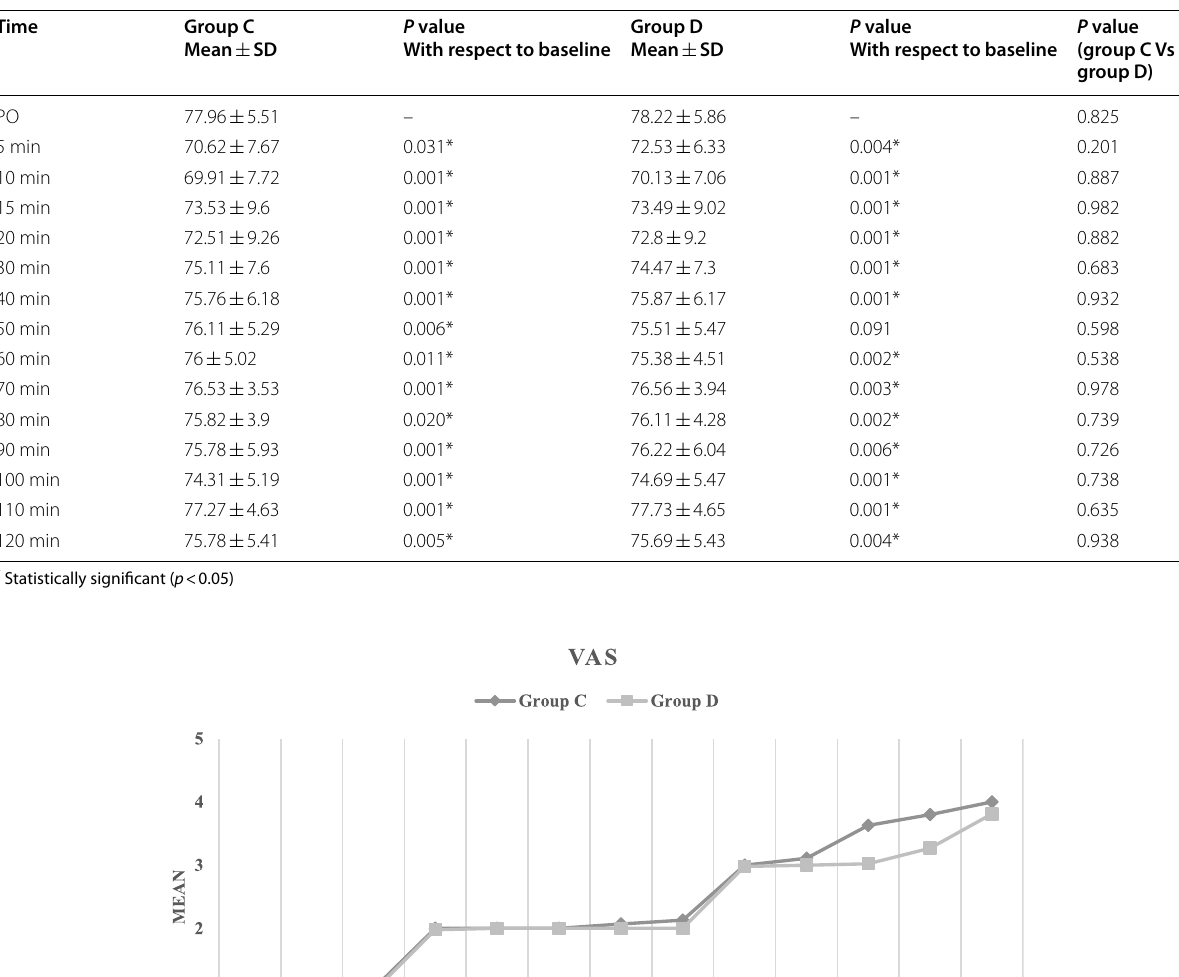
Table 2 Mean arterial pressure recorded perioperatively in both the groups